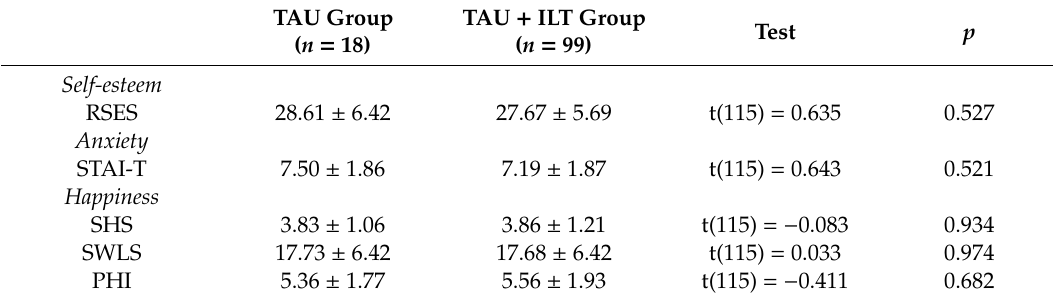
Table 3. Mean scores on the mental health scales administered prior to treatment